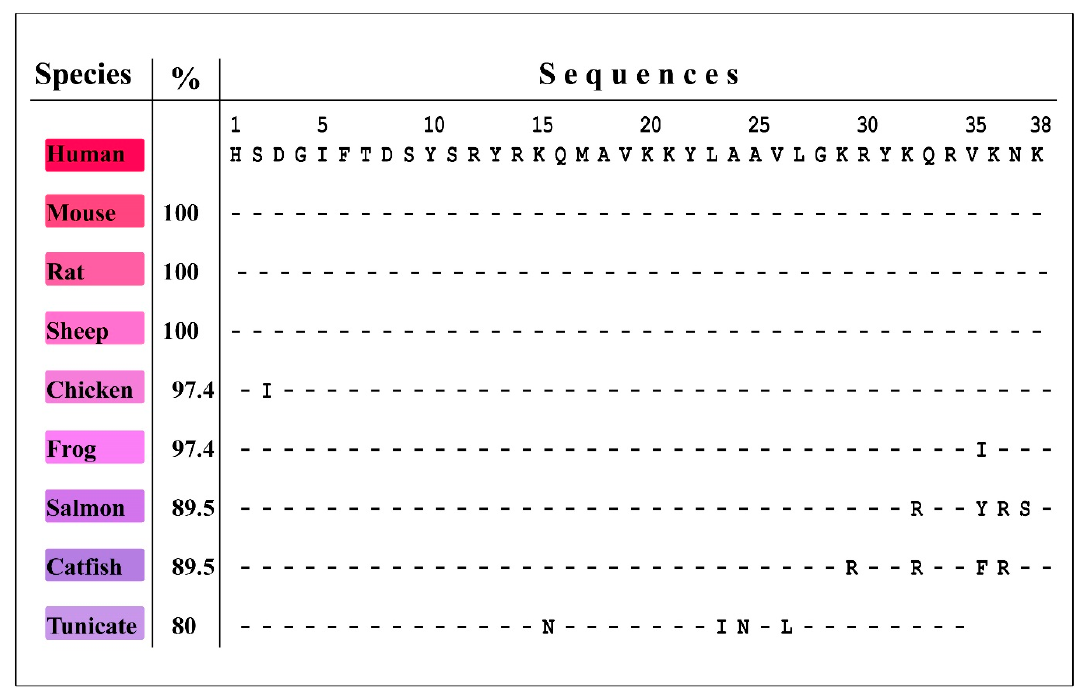
Figure 2. Comparison of species specific PACAP1-38 amino acid sequences (PACAP orthologs). The species names are indicated on the left. Percent homologies are calculated and shown in the “%” column on the left. Amino acids are given in the single letter code. The numbers on the top show their positions. Sequence comparison was performed by BLASTP v.2.9.0 search on Non-redundant GenBank CDS translations + PDB + SwissProt + PIR + PRF databases. Accession numbers: Human PACAP, (preproprotein) NP_001093203, Mouse, BAA28355, Rat, NP_058685, Sheep, AAB21469.1, Chicken,